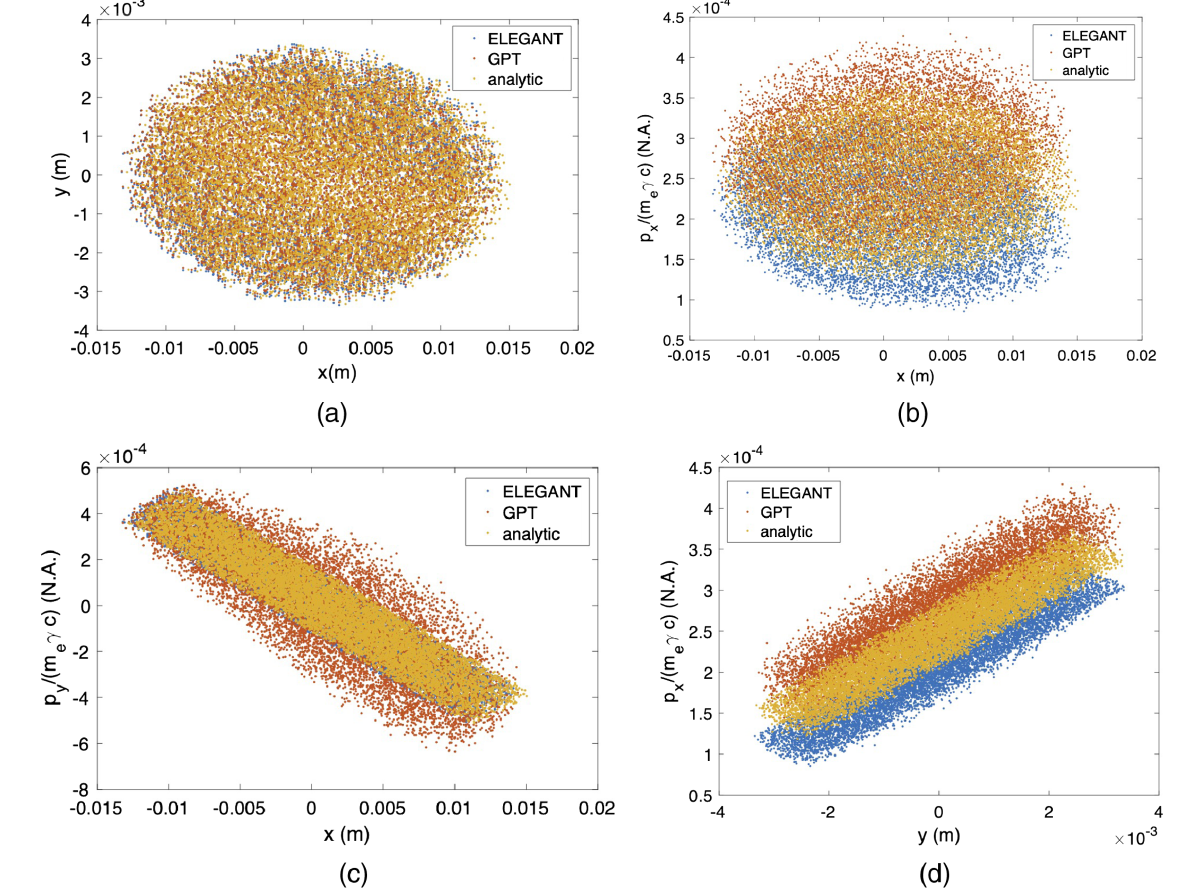
FIG. 17. Benchmark of ELEGANT code and analytic computations against GPT . (a) x − y distribution. (b) x − x 0 distribution. (c) x − y 0 distribution. (d) y − x 0